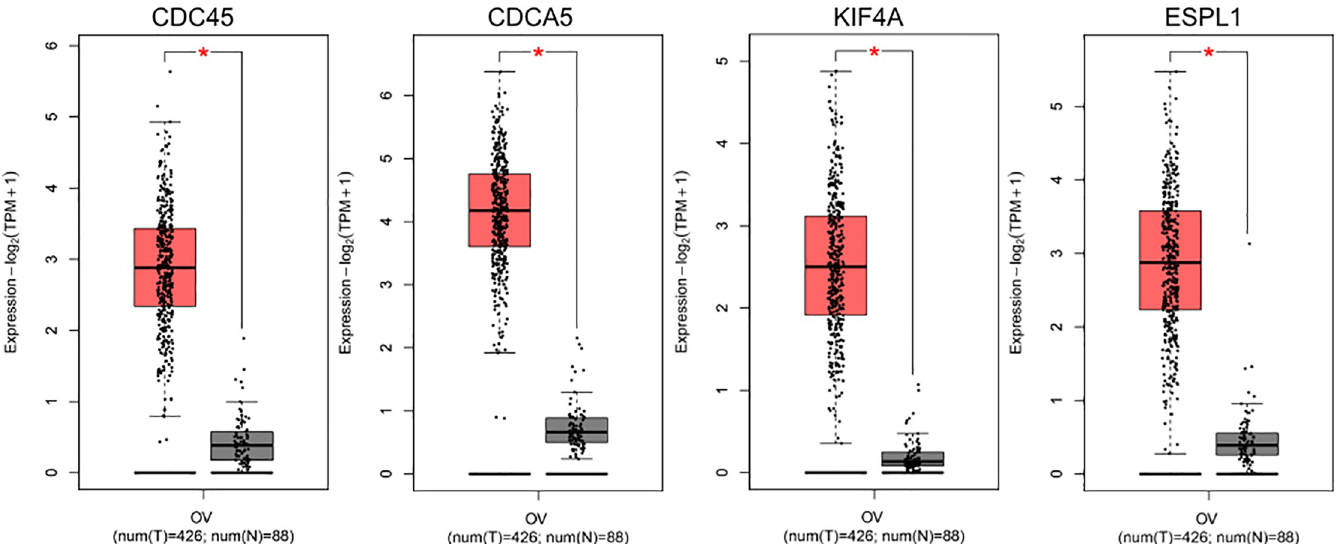
Fig 5. Validation of hub gene expression levels in GEPIA. The expression of CDC45, CDCA5, KIF4A, and ESPL1 in EOC tissues were significantly elevated compared with adjacent ovarian tissues. (a) CDC45; (b) CDCA5; (c) KIF4A; (d) ESPL1; � p < 0.05.